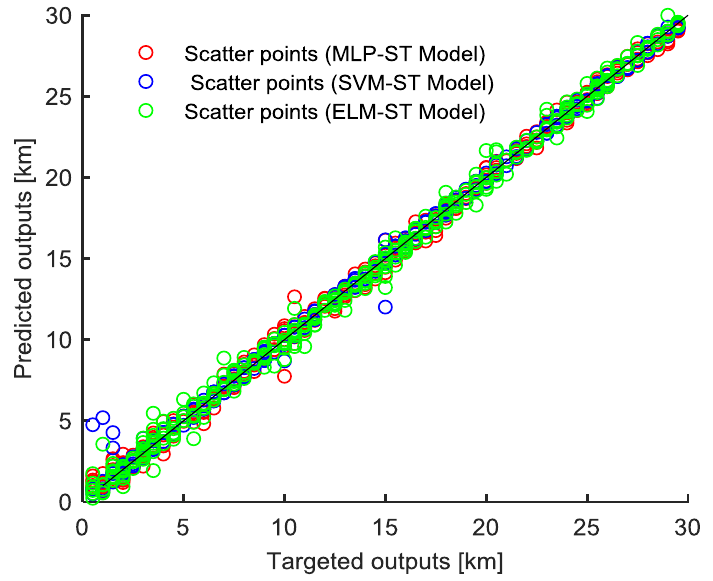
Figure 9. Scatter plot of the targeted and the ST based optimized MLT predicted outputs, for the test dataset, in the presence of 30 dB SNR.